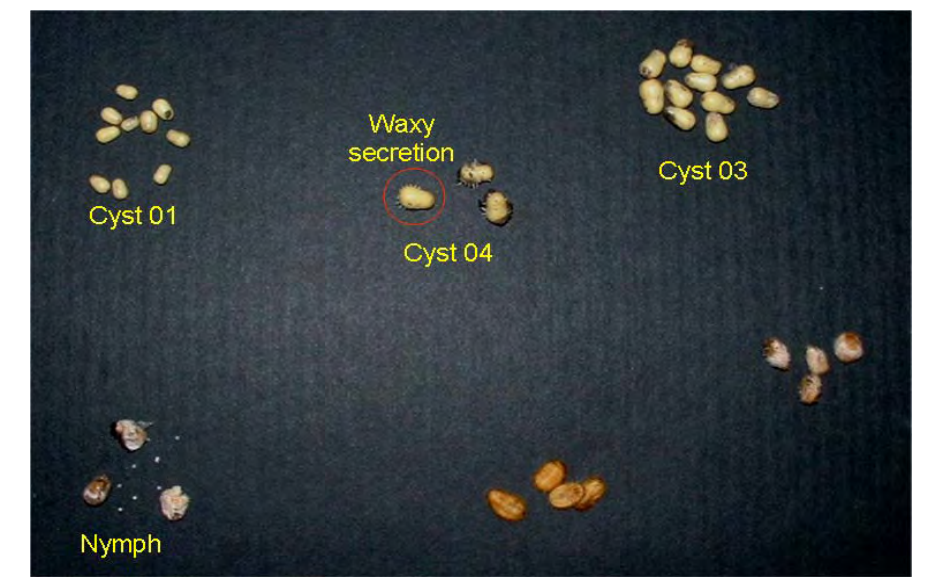
Figure 1. Stages in the Development of Eurhizococcus